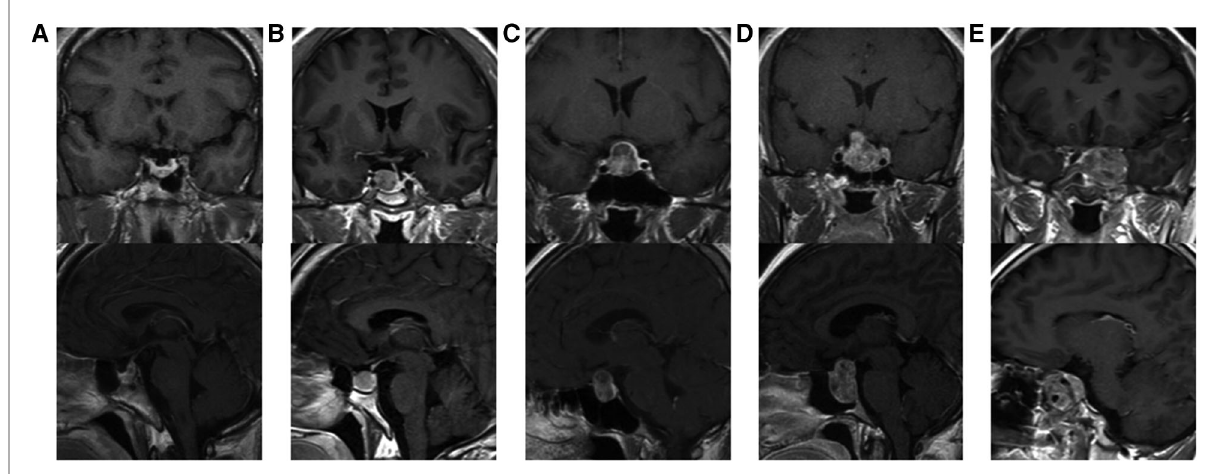
FIGURE 1 Knosp grades of patients. ( A ) Knosp 0, tumor is medial to medial tangent. ( B ) Knosp I, tumor extends to the space between the medial tangent and the intercarotid line. ( C ) Knosp II, tumor extends to the space between the intercarotid line and the lateral tangent. ( D ) Knosp III, tumor extends lateral to the lateral tangent. ( E ) Knosp IV, tumor with a complete encasement of intracavernous internal carotid artery.